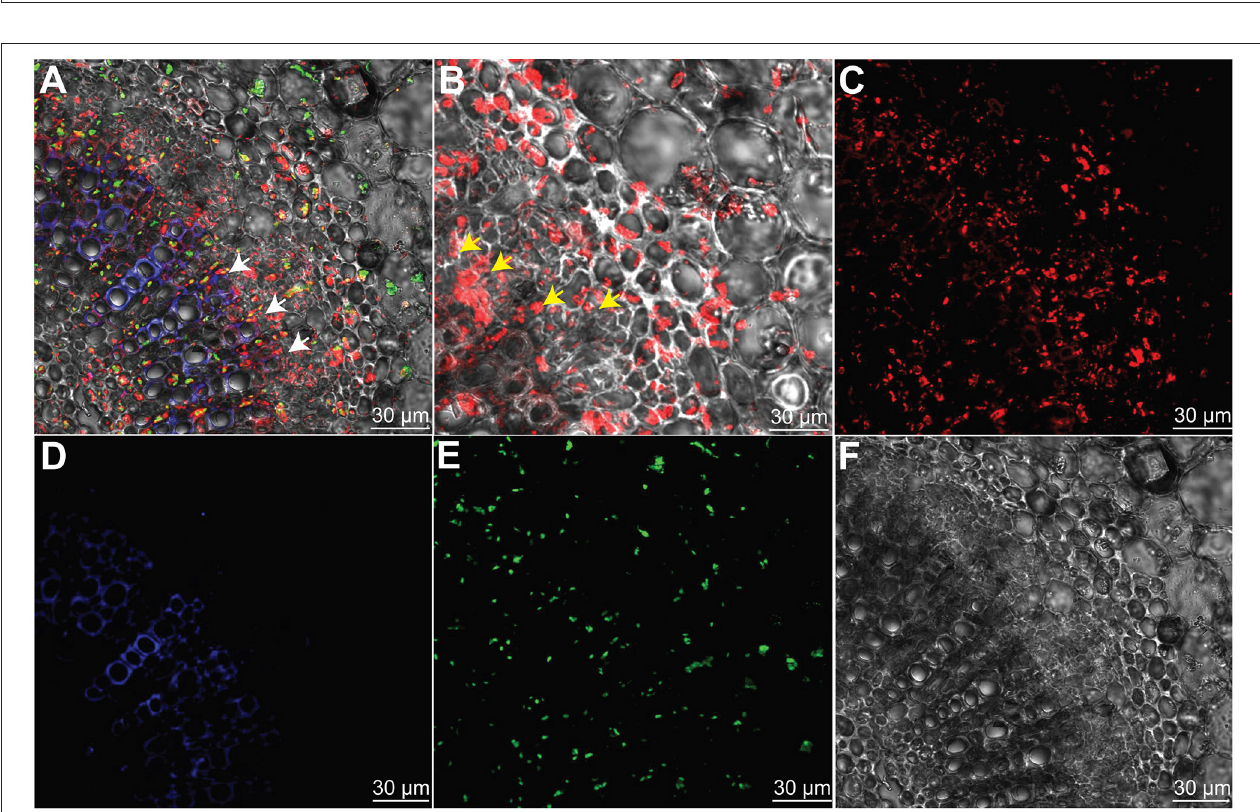
FIGURE 3 | Bacillus subtilis L1-21 colonization in the phloem of citrus leaves midribs. (A–E) Indigenous citrus endophyte expressing mKate2 was grown until the late log phase and foliar sprayed on citrus plants in the greenhouse. Confocal laser scanning microscope was carried for visualization of B. subtilis L1-21 red fluorescent protein ( RFP ) in phloem; (A) Transverse section of merged citrus leaves midrib displaying red fluorescence (phloem); green autofluorescence (chlorophyll); blue fluorescence depicted the xylem; (B) Enlarge part from panel A observed for details colonization of endophyte inside citrus leaves phloem; (C) Individual RFP of B. subtilis L1-21; (D) Xylem with blue autofluorescence; (E) Green autofluorescence generated by chlorophyll; and (F) Dark field showing citrus phloem. The scale represents the 30 µ M. The white and yellow arrows represent the localization of RFP-tagged B. subtilis L1-21 inside